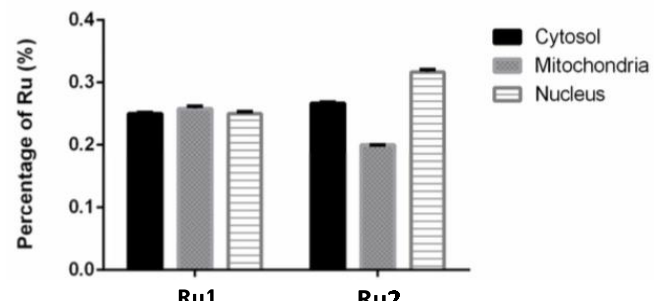
Figure 6. Subcellular distribution of Ru1 and Ru2 in MCF7 cell line. Cells were incubated in the presence of 60 μM of the complexes for 6 h. Data are presented as the mean ± SEM of two independent assays.